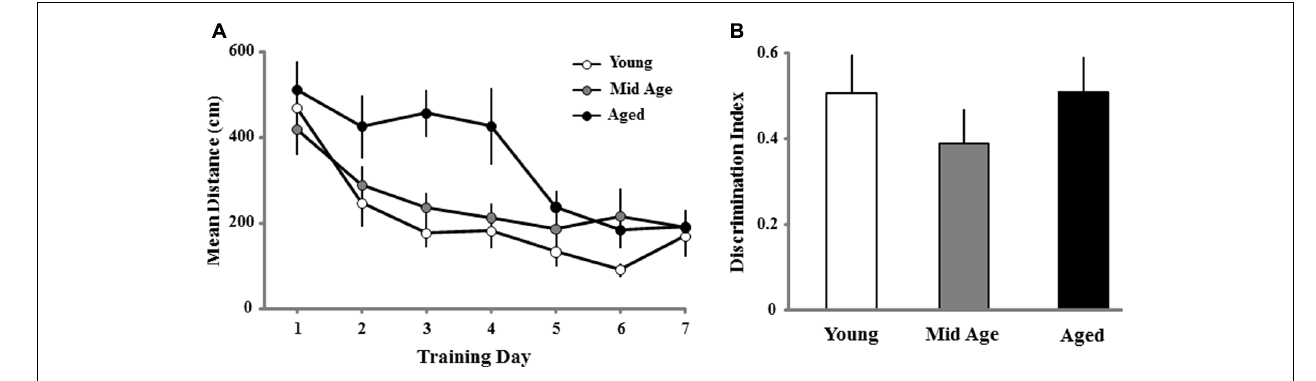
FIGURE 9 | For reference memory training across days, aged animals exhibit a slower rate of acquisition and no impairment in the maintenance of a reference memory. (A) Mean path length to find the escape platform during the long-term reference memory spatial discrimination task in the water maze. Data represents the mean distance traveled ( ± SEM) per training day (four trials/day) for young (open circle,